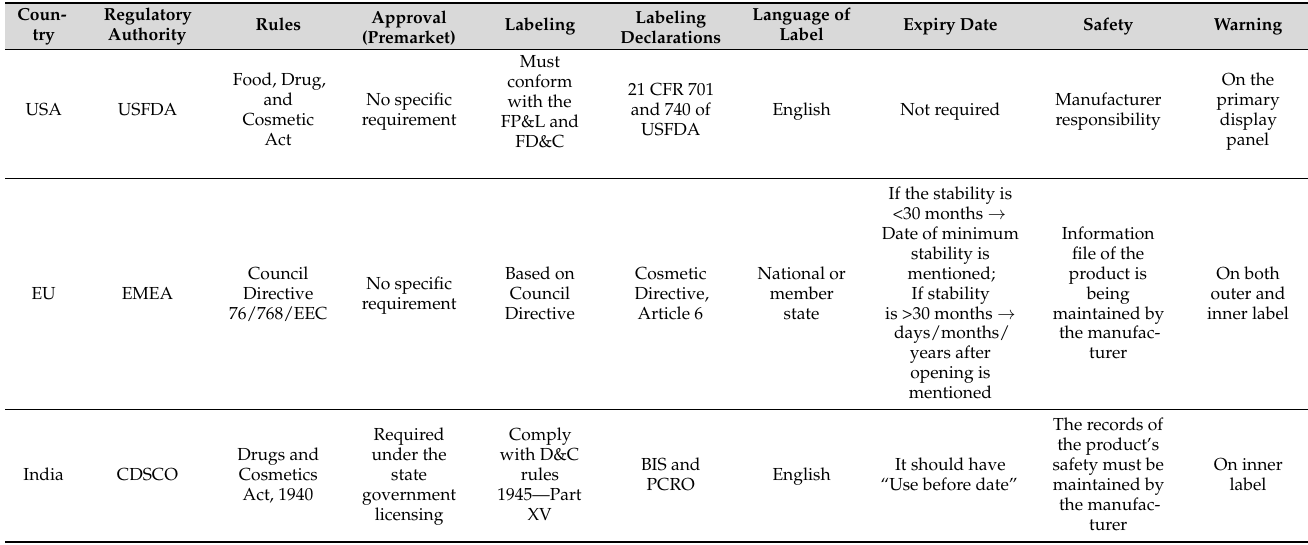
Table 4. Comparison of regulation of cosmetics/cosmeceuticals in the USA, the European Union, and India